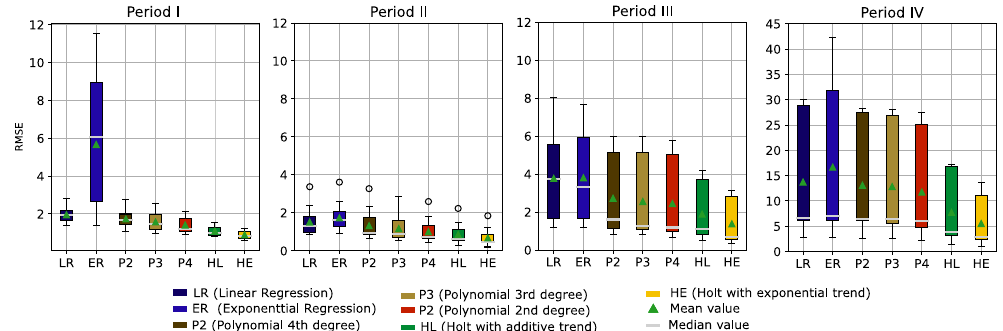
Figure 9. Boxplots of the root mean square error (RMSE) calculated for the trained models and categorized into four data